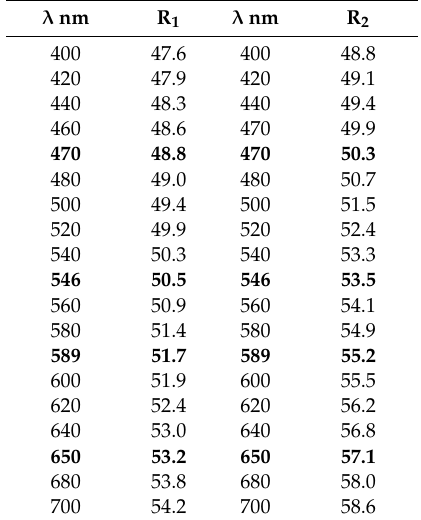
Table 2. Reflectance values for grammatikopoulosite. The values required by the Commission on Ore Mineralogy are given in